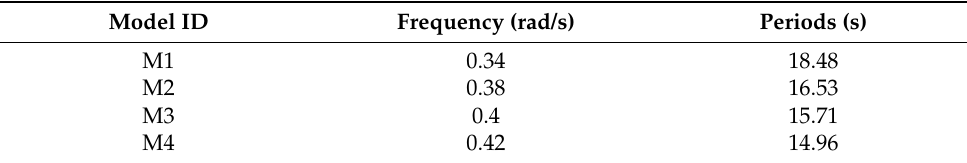
Table 3. Natural periods of different platforms for pitch at 0 ◦